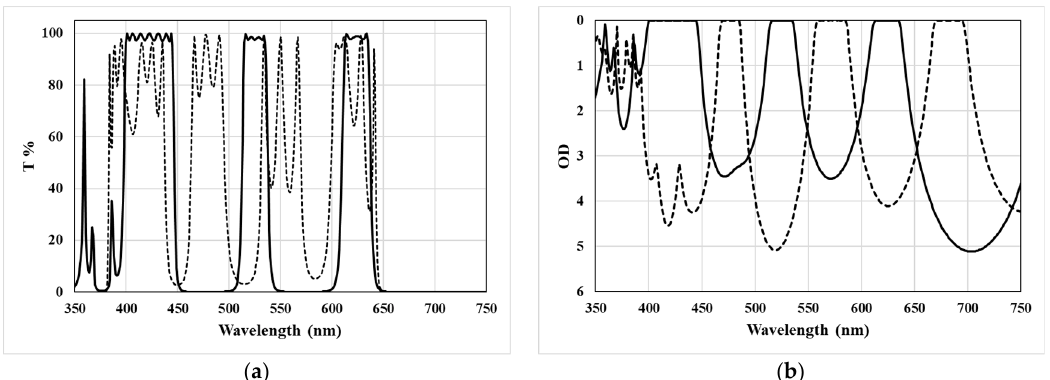
Figure 3. ( a ) Transmittance for the design of side 1, dotted line: before optimization; solid line: after optimization; ( b ) Optical densities (ODs) of the designs for side 1 and side 2 of 3D glasses, solid line: side 1; dotted line: side 2.